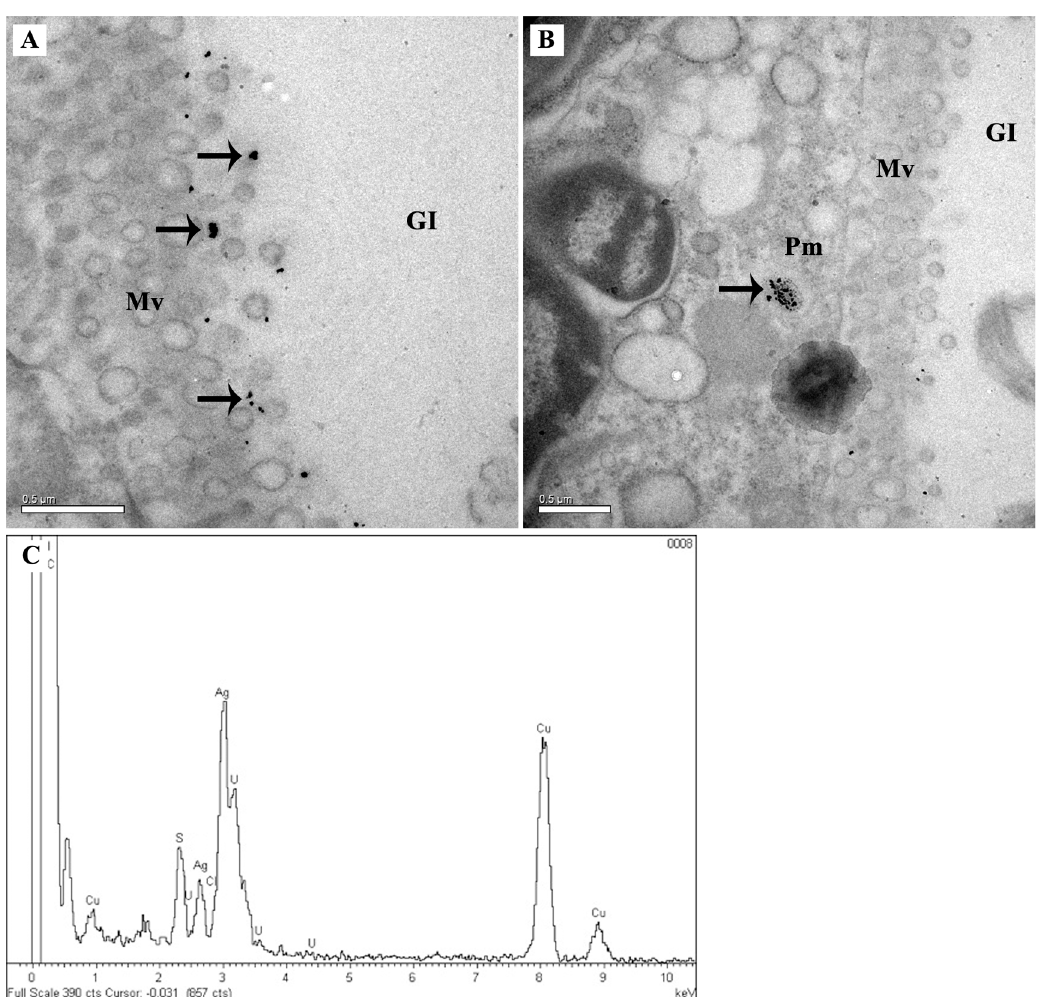
Fig 9. TEM micrographs of coated AgNP localization in C . onyx larva. Coated AgNPs were found in the intestine region of C . onyx treated with 100 μ g L -1 of PAgNPs. Particles are visible in the intestine as black dots indicated by arrow. They are also observed to pass through the plasma membrane and deposit next to the microvilli (A) and in the vacuole (B). Gl: gut lumen; Mv: microvilli; Pm: plasma membrane. Scale bars: 0.5 μ m. (C) is the EDS spectrum showing the presence of